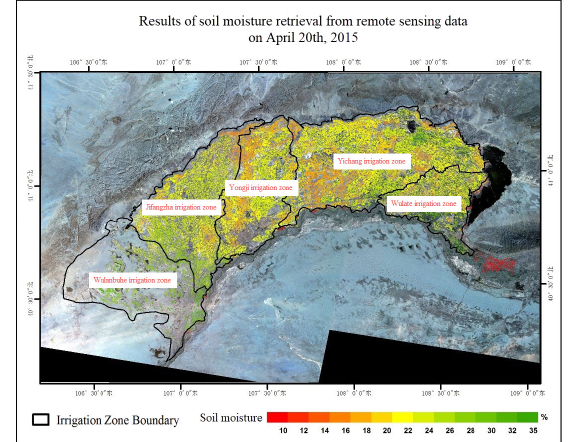
Figure 7. Remote sensing retrieval results of soil moisture